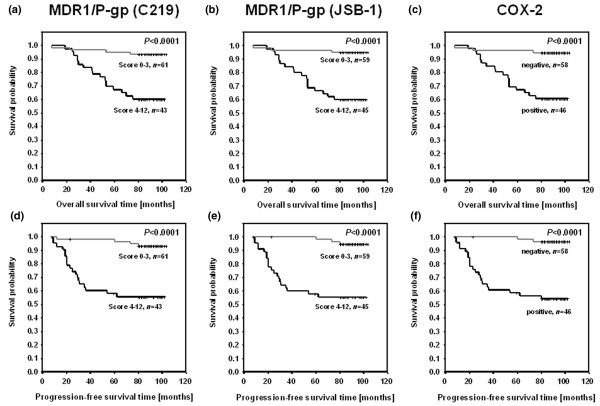
Kaplan-Meier analysis of the complete group of 104 breast cancer patients. (a) Patients with a lower overall immunoreactivity score for MDR1/P-glycoprotein (MDR1/P-gp) expression detected with antibody C219 exhibit significantly longer overall survival. (b) Patients with a lower overall immunoreactivity score for MDR1/P-gp expression detected with antibody JSB-1 exhibit significantly longer overall survival. (c) Cyclooxygenase-2 (COX-2) negative cases exhibit significantly longer overall survival. (d) Patients with a lower overall immunoreactivity score for MDR1/P-gp expression detected with antibody C219 exhibit significantly longer progression-free survival. (e) Patients with a lower overall immunoreactivity score for MDR1/P-gp expression detected with antibody JSB-1 exhibit significantly longer progression-free survival. (f) COX-2 negative cases exhibit significantly longer progression-free survival.